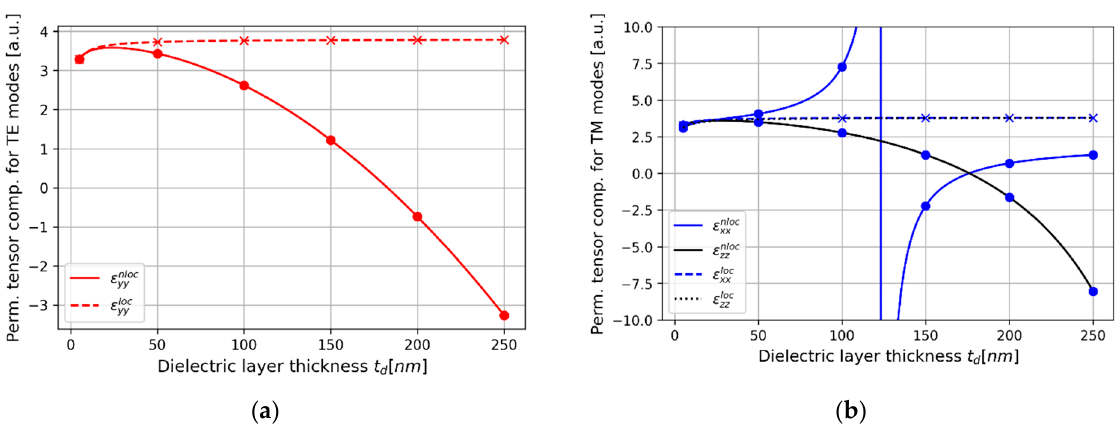
Figure 3. Real parts of local and nonlocal permittivity tensor components for TE- ( a ) and TM-polarized waves ( b ) as a function of dielectric thickness. The cases selected for analysis, i.e., t d = t ZnO = 5 (case 1), 50 (case 2), 100 (case 3), 150 (case 4), 200 (case 5), 250 nm (case 6) have been denoted with dots for nonlocal curves and x-marks for local